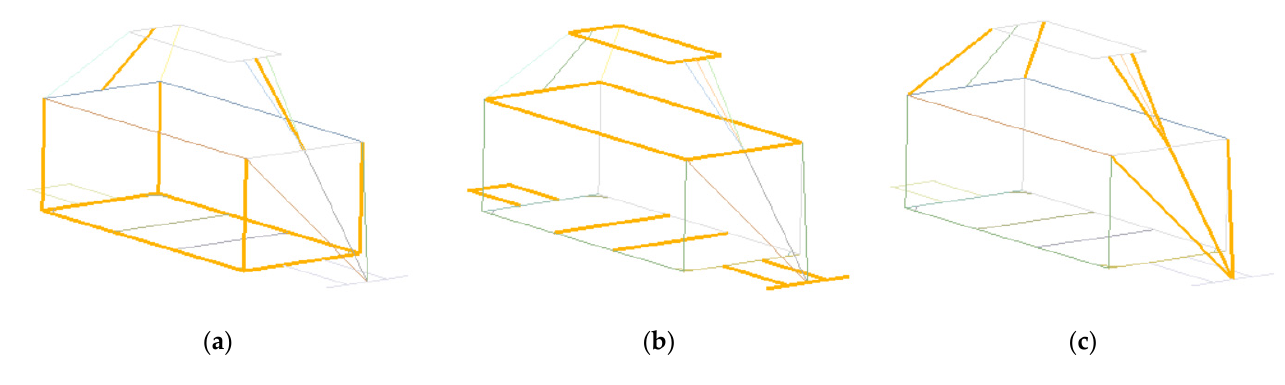
Figure 2. ( a ) Marginal conditions and FEM model load; ( b ) dimension optimization of the sections